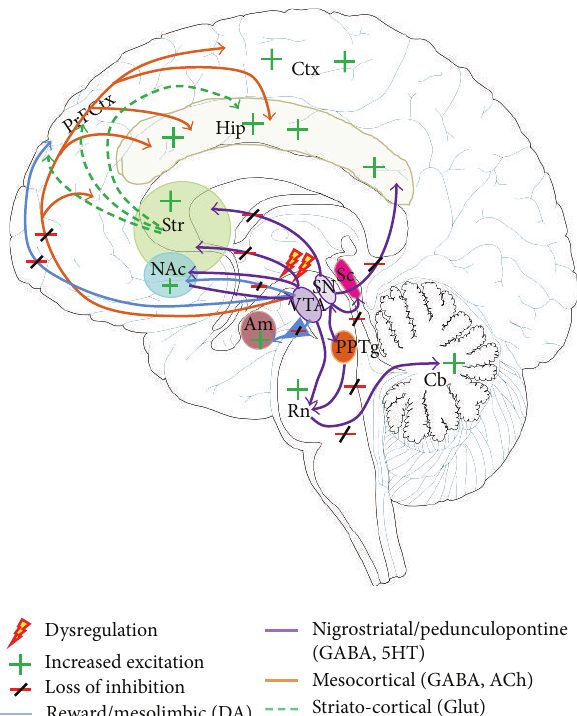
Figure 2: Pathways in the brain implicated in the clinical presentation of mefloquine toxicity. Loss of ascending inhibition within the nigrostriatal-pedunculopontine, mesolimbic and mesocortical pathways, resulting in hyperactivation of neurons in the amygdala, striatum, nucleusaccumbens,andcorticalandhippocampalareas,aswellaswithindescendingpathwaystotheRaphenuclei,andcerebellumcouldgive rise to the complex neuropsychiatric sequelae observed in patients exposed to prophylactic and treatment doses of mefloquine. Secondary disinhibition of striato-cortical pathways is implicated in seizure and motor and cognitive changes observed in affected